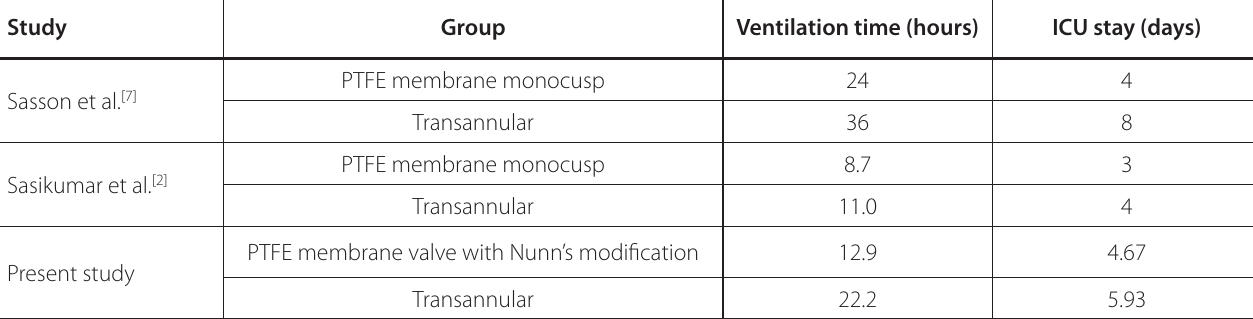
Table 7 . Other studies versus the present study comparing postoperative ventilation time/ICU stay.